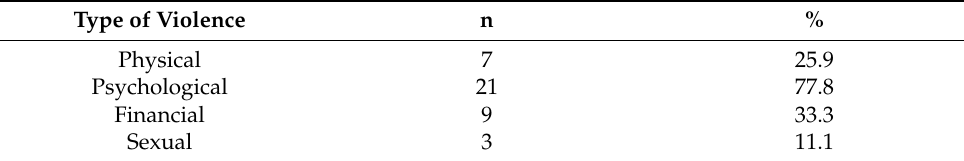
Table 1. Types of violence experienced by participants victims of violence (n =